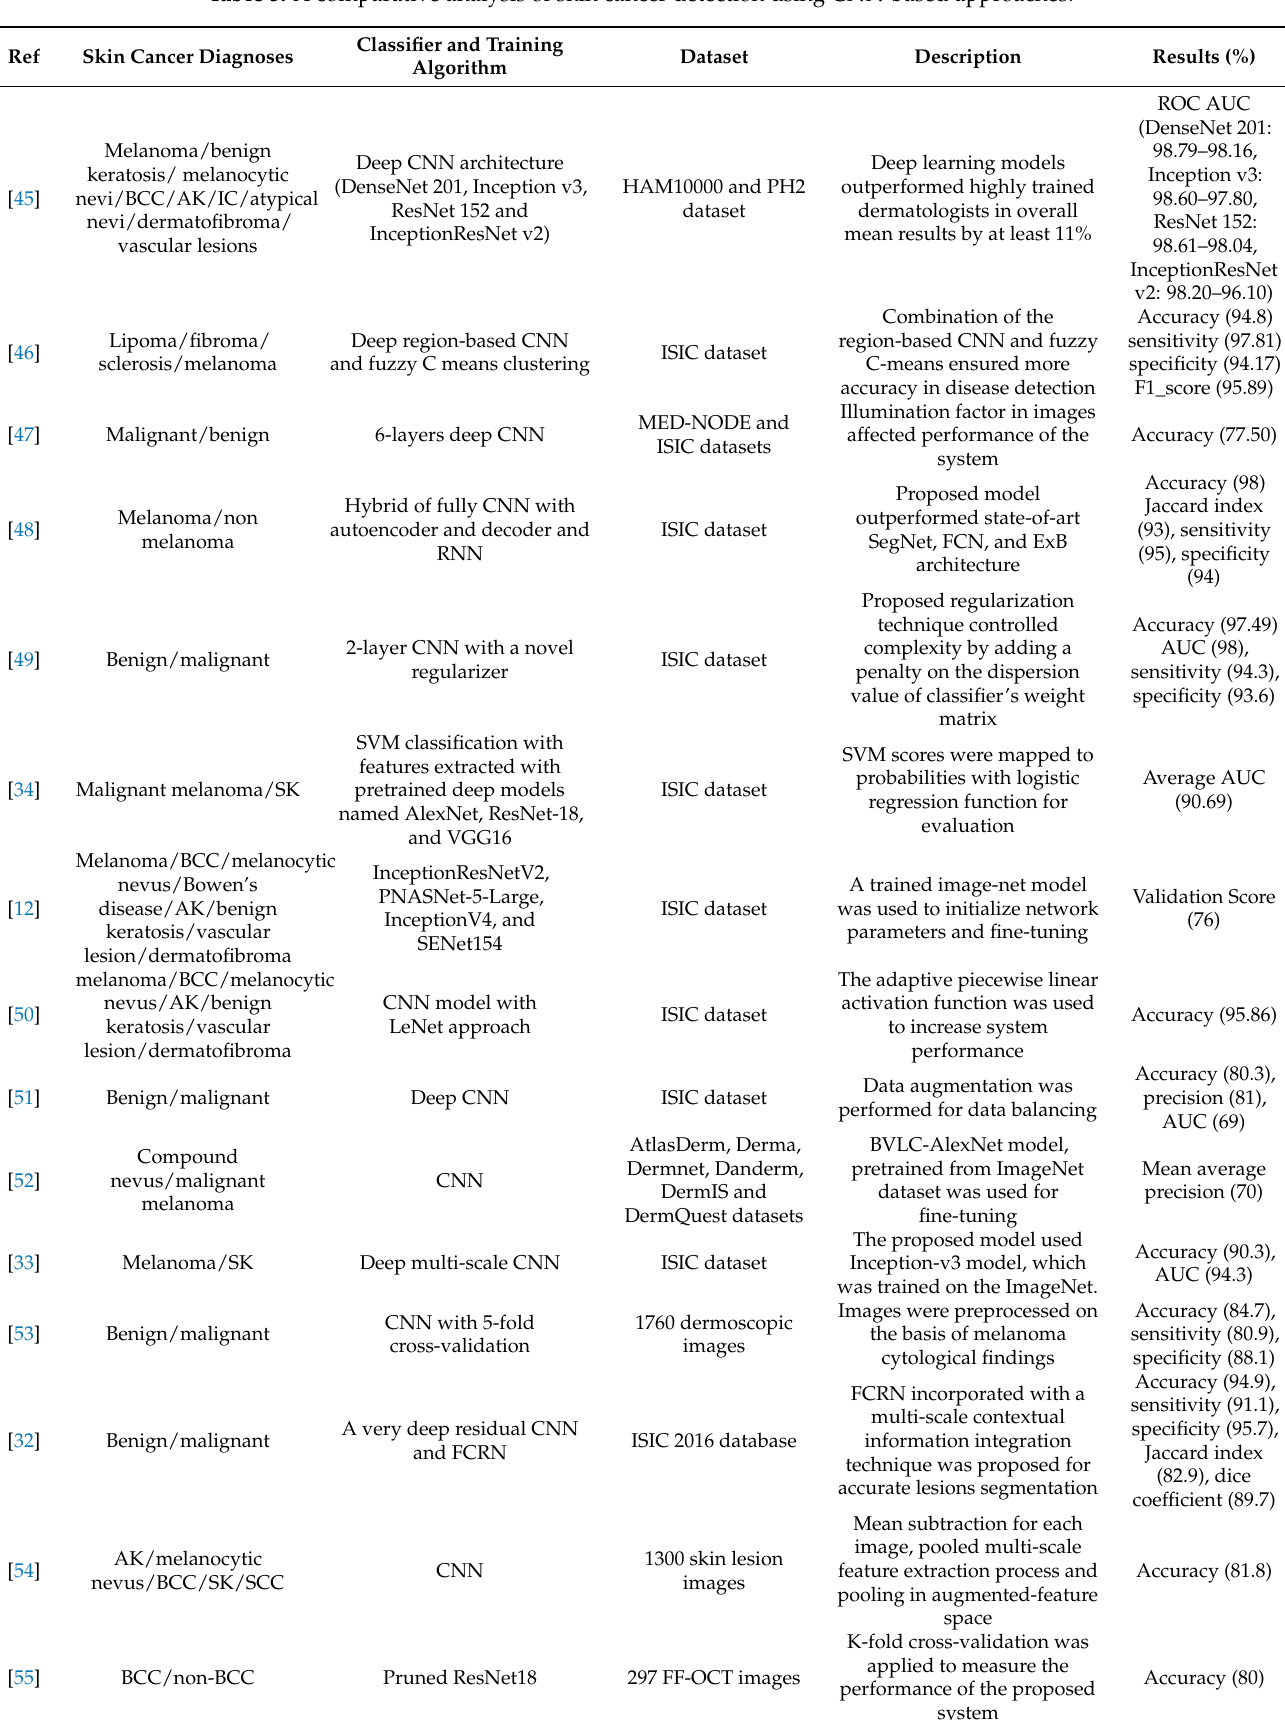
Table 5. A comparative analysis of skin cancer detection using CNN-based